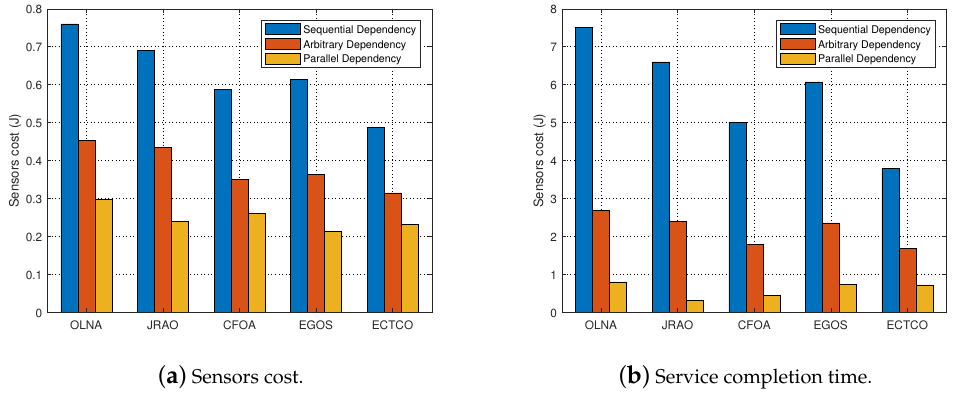
Figure 6. Impact of different dependency relationships. Table 6. Sensors cost versus dependency